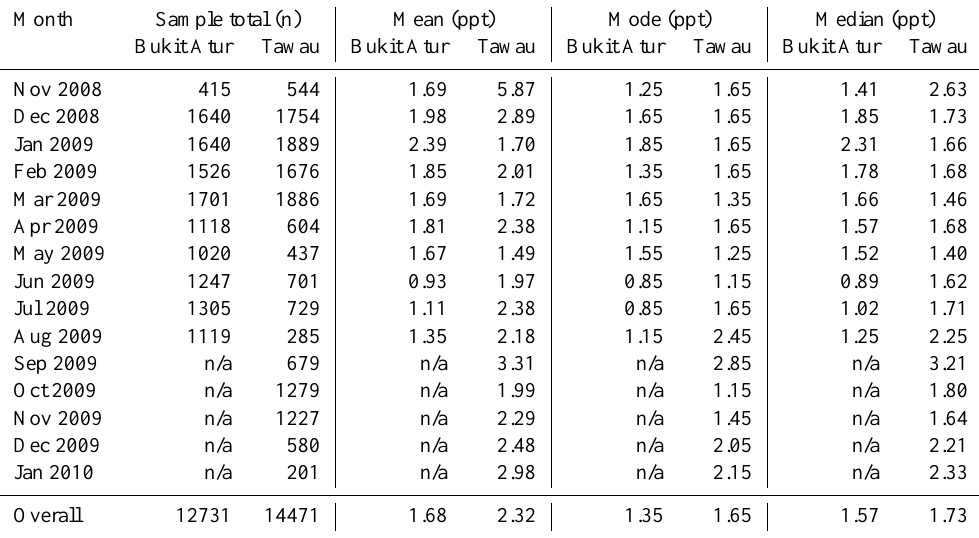
Table 3b. Statistical summary for CHBr 3 at Bukit Atur and